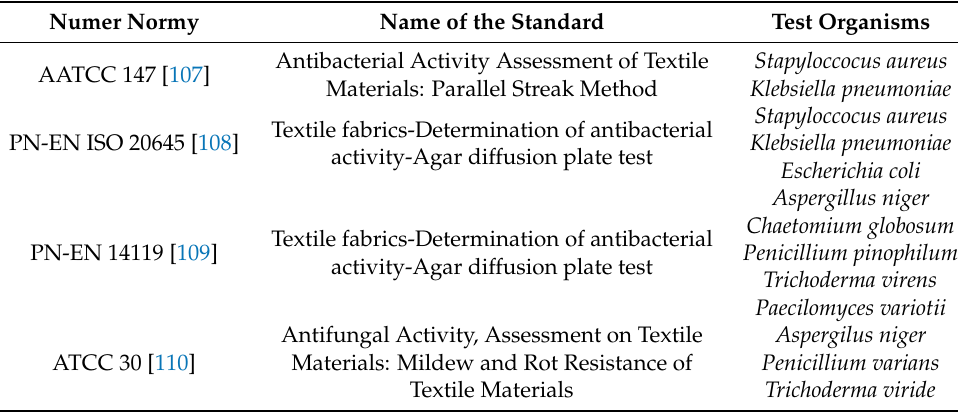
Table 4. Qualitative methods for the assessment of antimicrobial activity. Numer Normy Name of the Standard Test Organisms AATCC 147